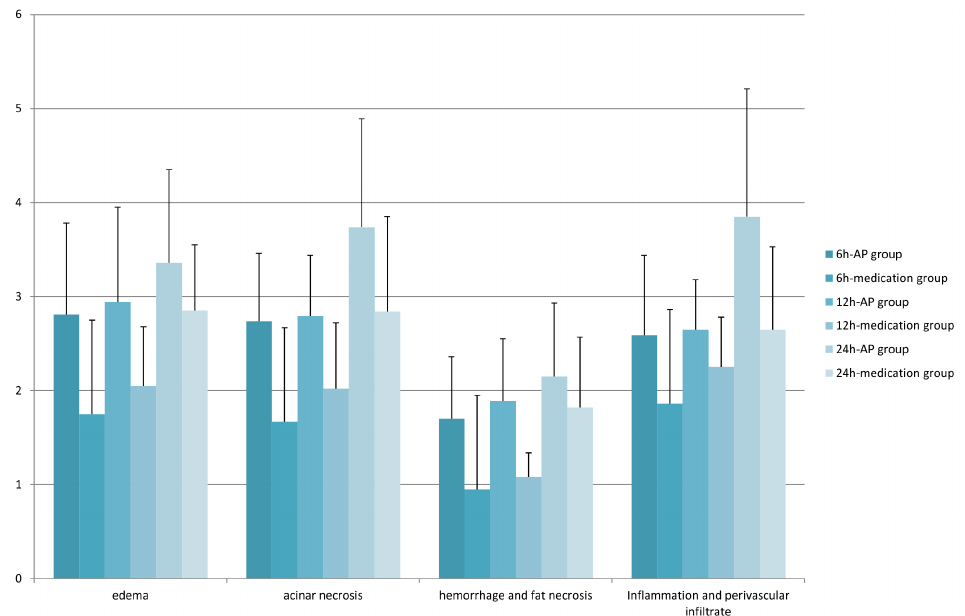
FIGURE 2 - Schmidt scores for the acute pancreatitis (AP) and medication groups. * p < 0.05 for comparison between the corresponding groups (6-h AP group vs 6-h medication group; 12-h AP group vs 12-h medication group; 24-h AP group vs 24-h medication